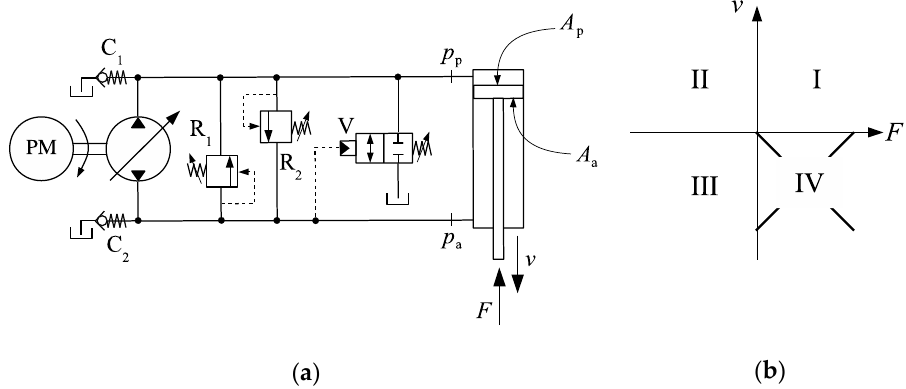
Figure 2. ( a ) Frankenfield’s circuit; ( b ) external force versus velocity quadrant Figure 2. (a) Frankenfield’s circuit; (b) external force versus velocity quadrant representation.